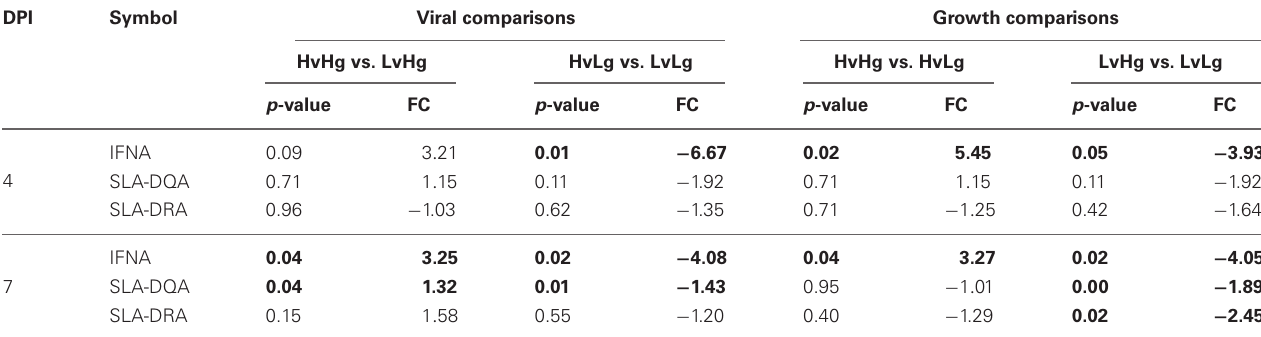
Table 3 | Test of immune gene expression for genes not present in the microarray platform.